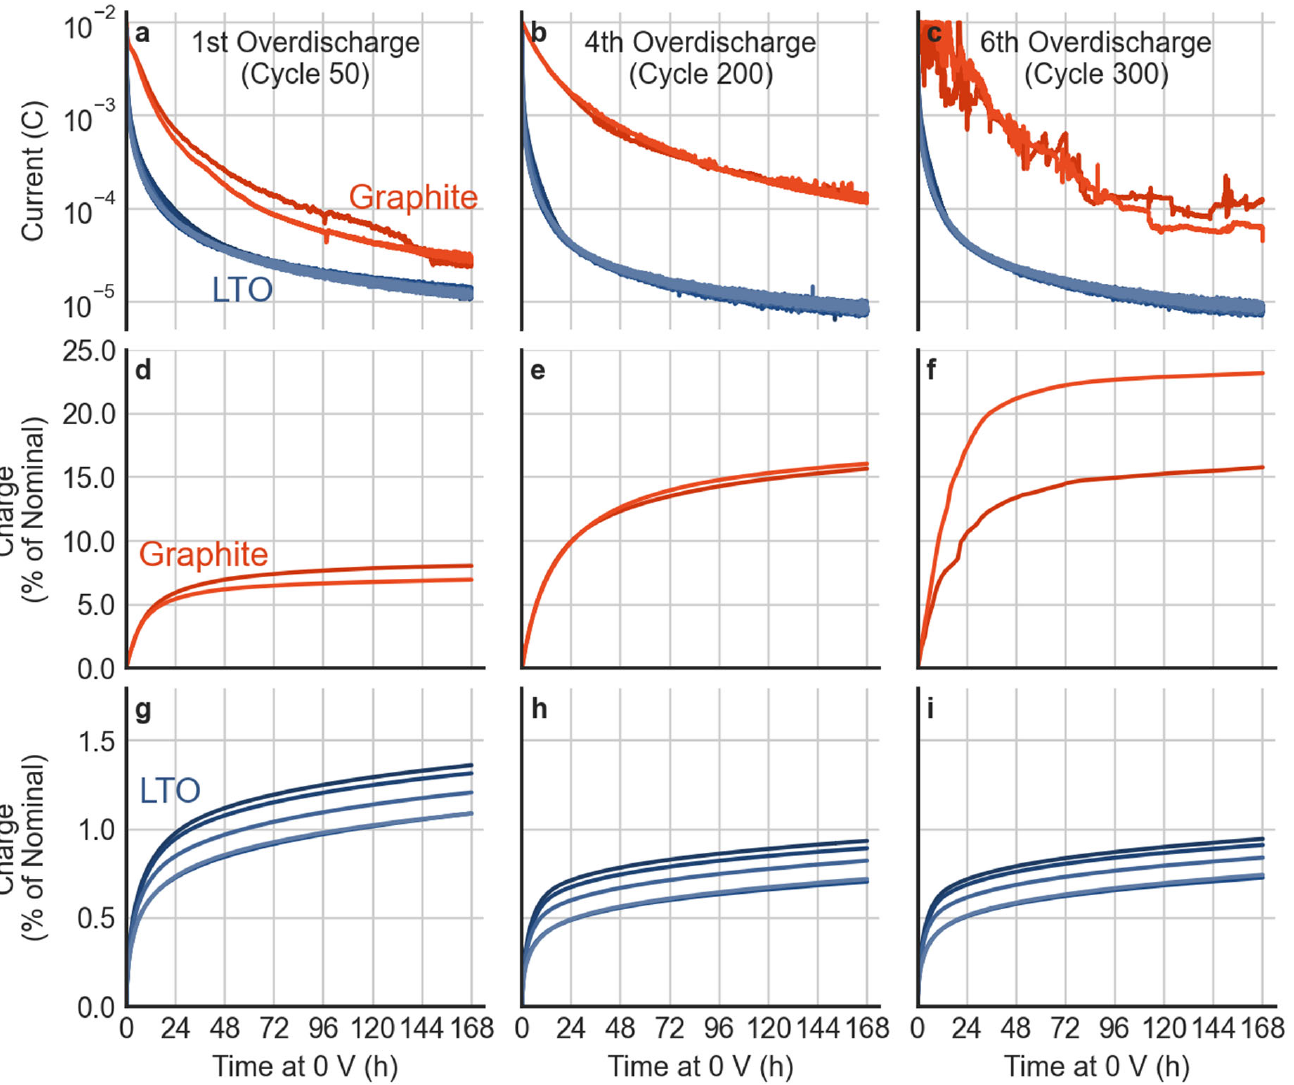
Figure 5. Current ( a – c ) and charge ( d – i ) vs. time for selected 0 V holds. The top row shows both graphite (red) and LTO (blue) cells. The charges passed for graphite ( middle row ) and LTO ( bottom row ) are presented separately. The left column ( a , d , g ) shows the first overdischarge. The middle column ( b , e , h ) shows the fourth overdischarge, and the right column ( c , f , i ) shows the sixth overdischarge.